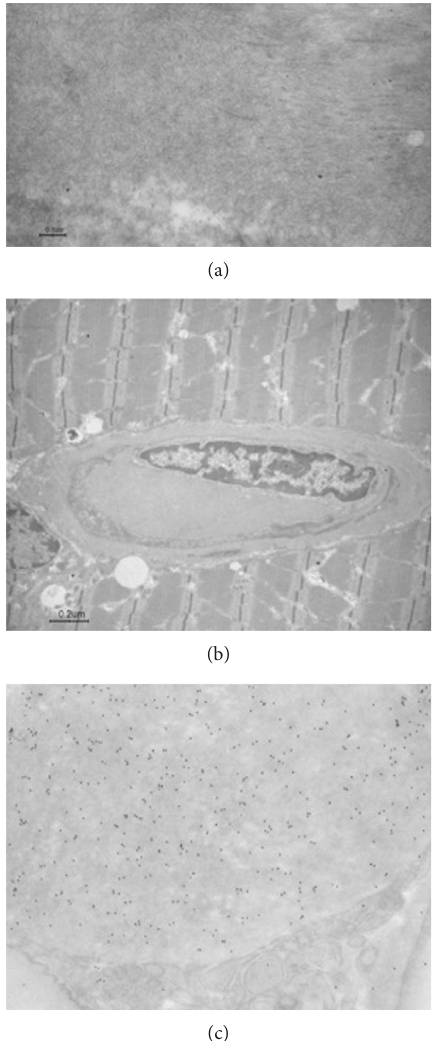
Figure 2: Presence of amyloid fibrils confirmed by electron mi- croscopy. Muscle biopsy was routinely fixed in 2.5% glutaraldehyde in cacodylate buffer, postfixed in osmium tetroxide, and dehy- drated and embedded in Araldite; thin sections were studied under Philips CM100 TEM fibrillary structures likely resembling amyloid fibrils in the perimysial pericapillary area (a) (bar � 0.1 µ m); an endomysial capillary lumen with a lightly thicker wall without amyloid fibrils (b) (bar � 0.2 µ m). Postembedding immunostaining with a polyclonal anti-kappa light chain antibody (Dako, 1 : 100) thin section was studied under a Jeol JEM-1400 Plus electron microscope